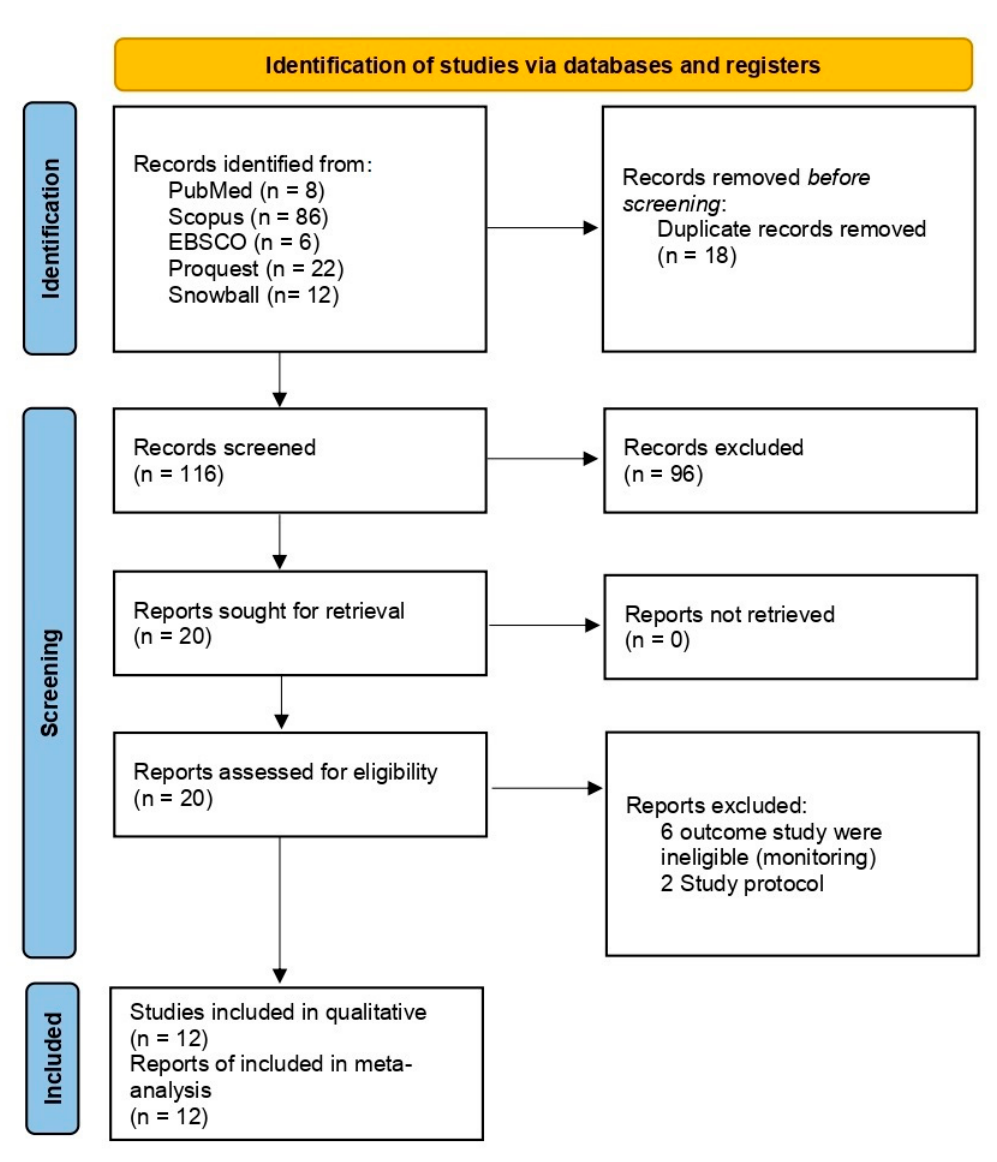
Figure 1. PRISMA flow diagram.